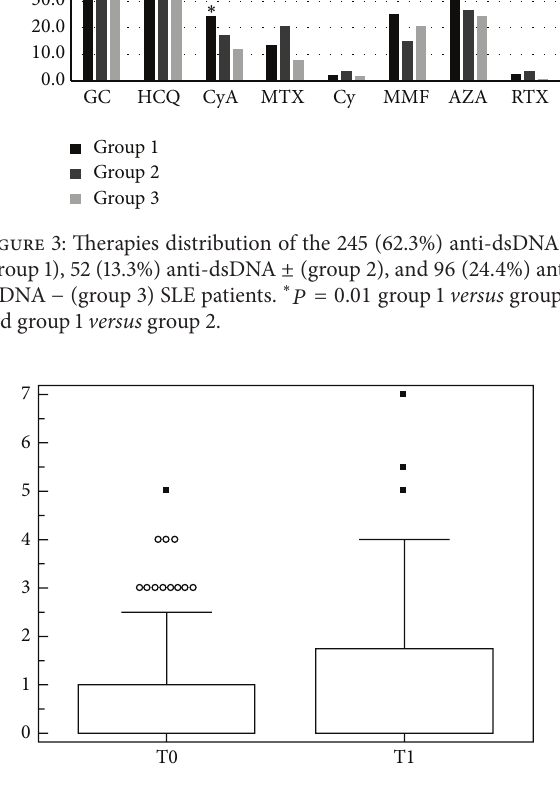
Figure 4: Mean ECLAM values before (T0) and after (T1) modifica- tion of anti-dsDNA status . Box and whiskers plot (median, quartiles, range, and possible extreme